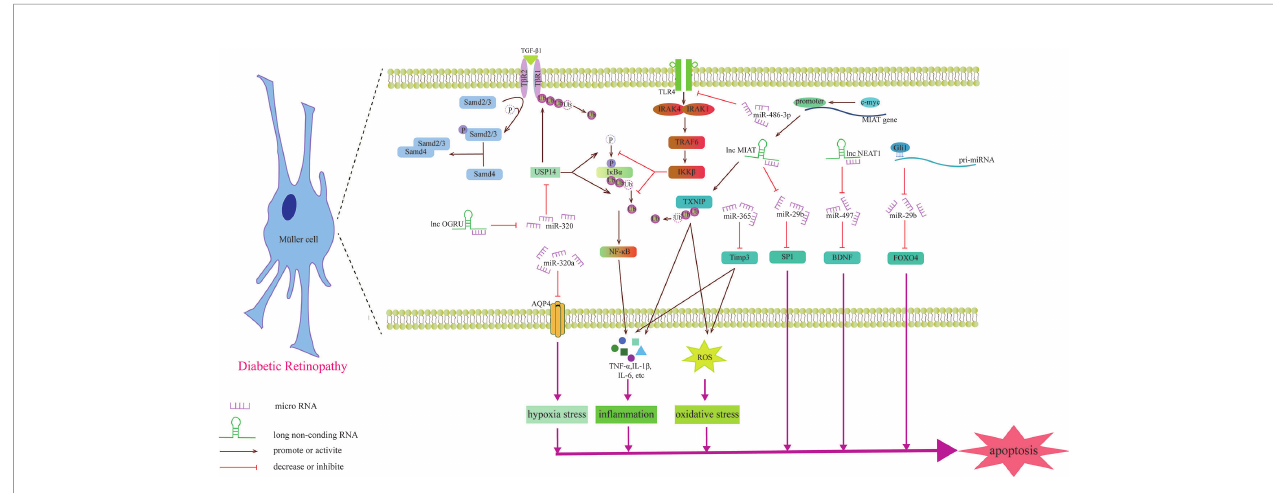
FIGURE 4 | Schematic diagram of the mechanism by which miRNAs and lncRNAs affect Müller cells and participate in the development of DR.